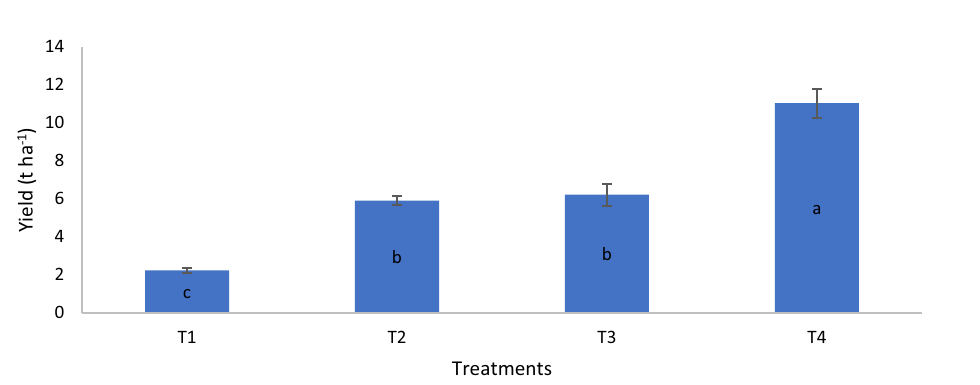
Figure 7. Chicken litter biochar on numbers of panicles of MR219 rice plants cultivated on a tropical acid soil.